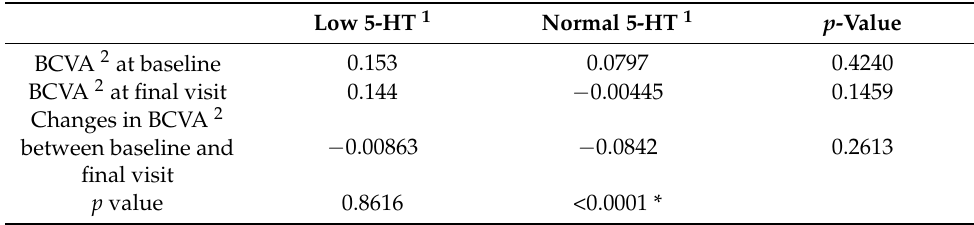
Table 3. Changes in best corrected visual acuity.